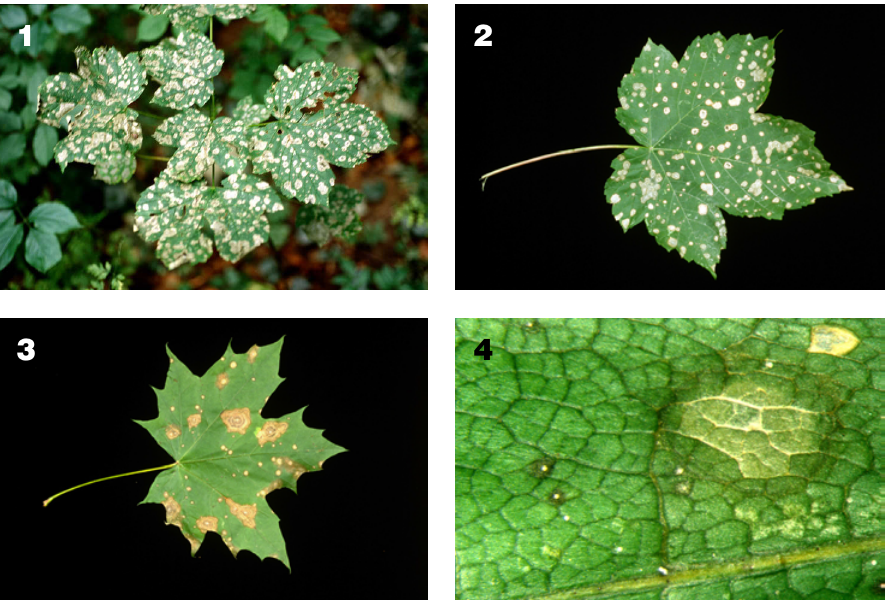
Figs 1-4. 1. A young sycamore ( A. pseudoplatanus ) with symptoms of infection by C. depraedans on all leaves in the crown; 2. A leaf of A. pseudoplatanus with numerous necrotic spots caused by C. depraedans ; 3. A leaf of A. platanoides with numerous necrotic spots caused by C. depraedans ; 4. A leaf of A. platanoides with the local lesions of different size resulting from different infection times by C. depraedans